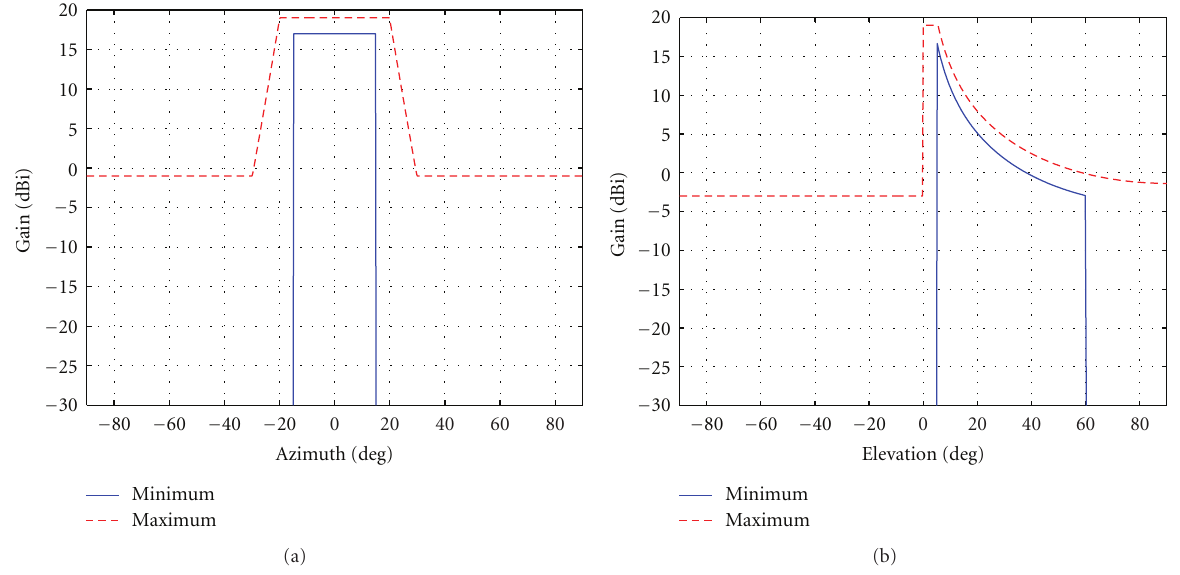
Figure 2: Pattern requirements in azimuth (a) and elevation (b). Maximum (dashed lines) and minimum (solid lines)